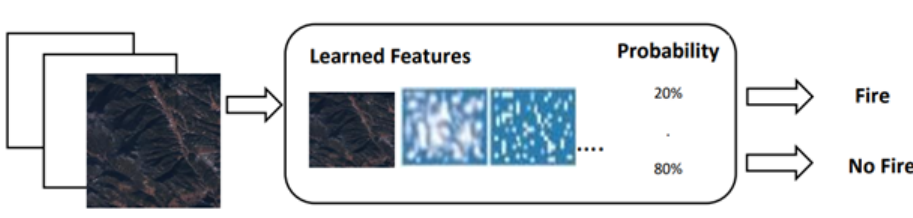
Figure 3. Deep learning workflow: Images are passed to the CNN to learn features and classify objects